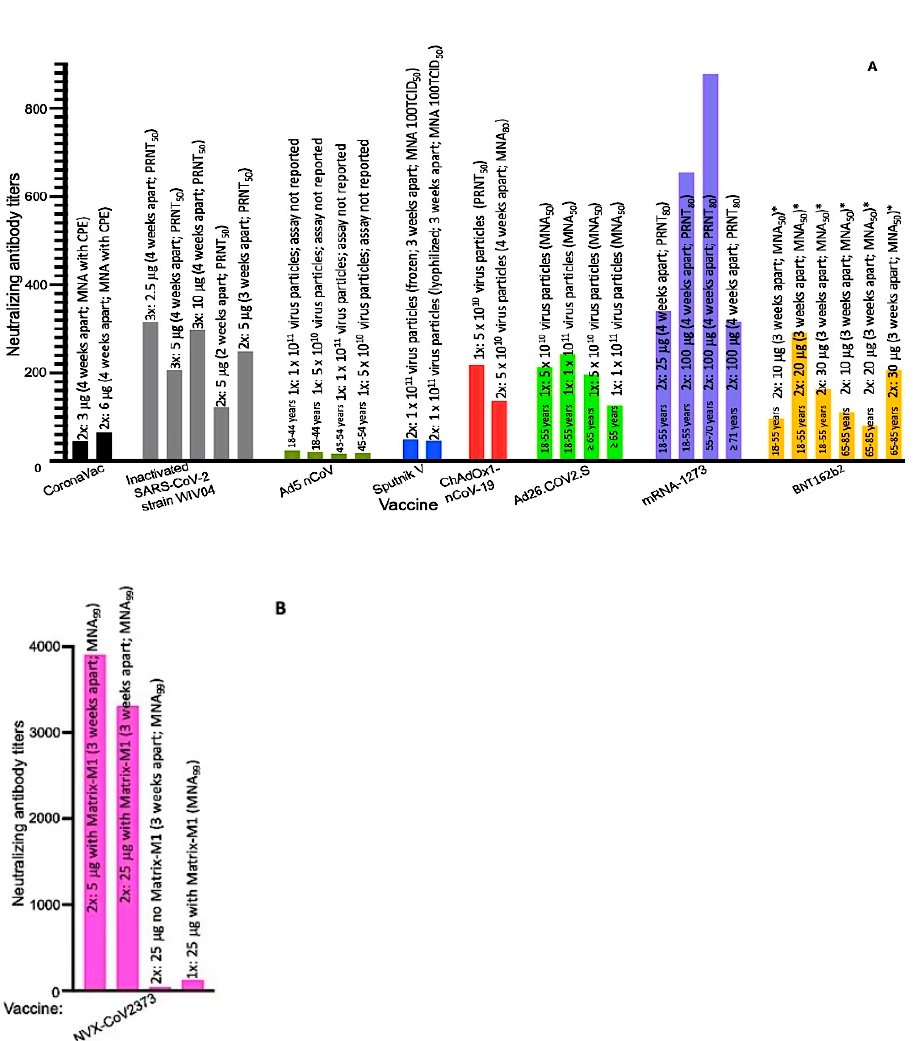
Figure 1. NGMATs of SARS-CoV-2 candidate vaccines in phase III trials. ( A ) NGMATs of CoronaVac, inactivated SARS-CoV-2, Ad5 nCoV, Sputnik V, ChAdOx1 nCoV-19, Ad26.COV2.S, mRNA-1273, and BNT162b2. ( B ) NGMATs of NVX-CoV2373. Neutralization assays were performed using wild-type virus except with the BNT162b2 vaccine (* a reporter SARS-CoV-2 virus expressing mNeonGreen was used). Tissue culture infectious dose (TCID).